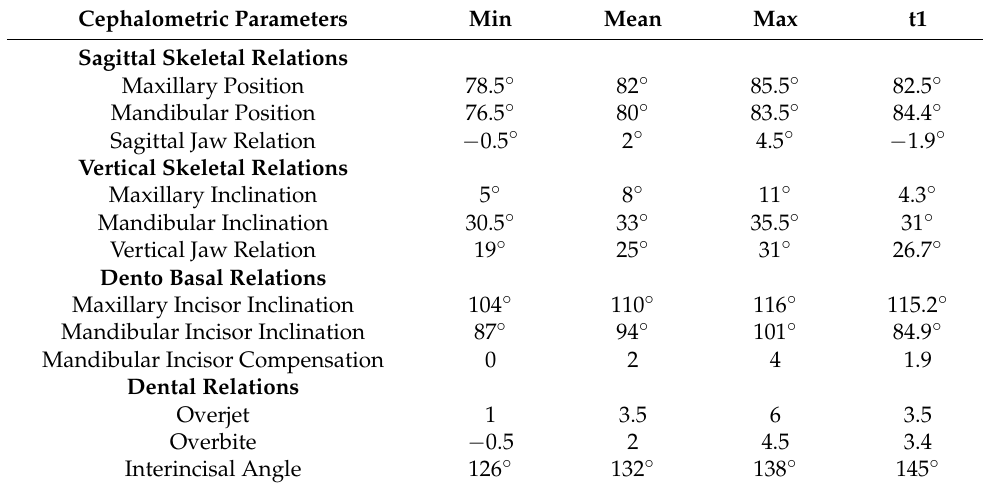
Figure 7. Patient X-rays and cephalometry after treatment: Orthopanoramic X-ray ( A ); Latero-lateral skull X-ray ( B ); Cephalometric tracing ( C ). Table 2. Final cephalometric